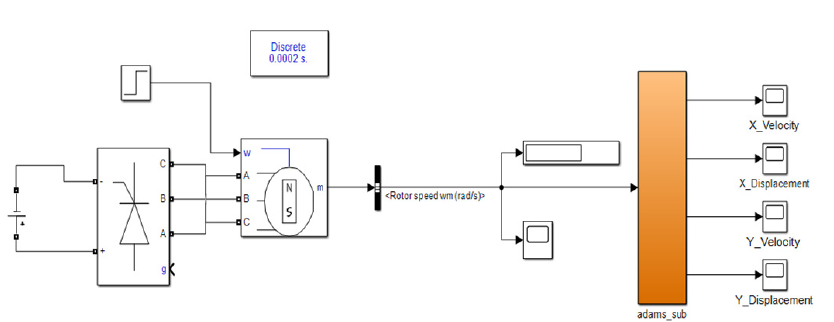
Figure 6. Digital twin model of planetary gearbox.